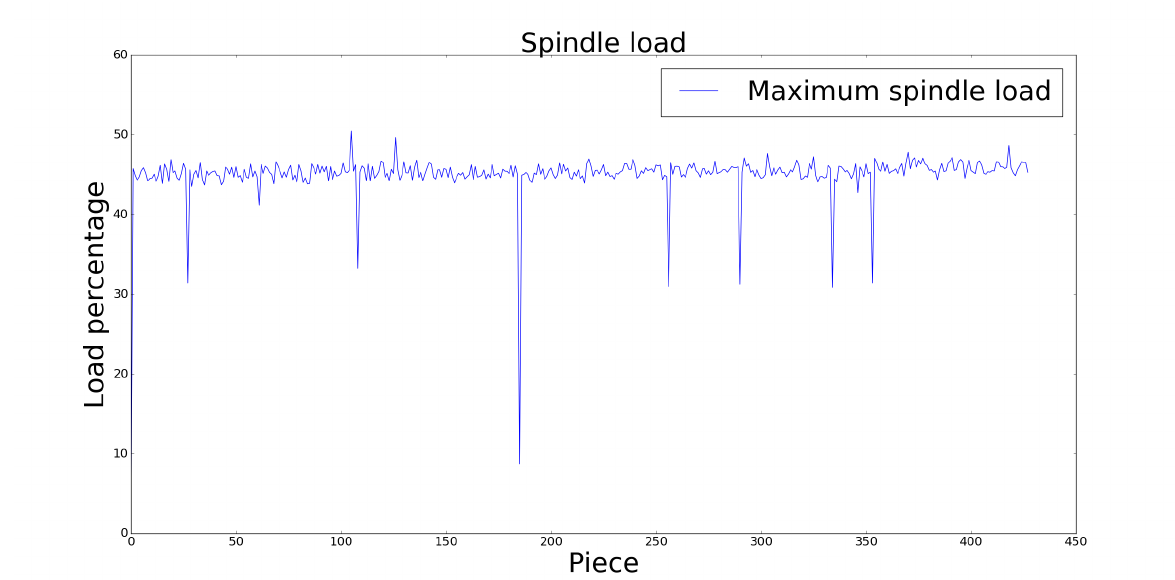
Figure 3. One time series spindle load before outlier